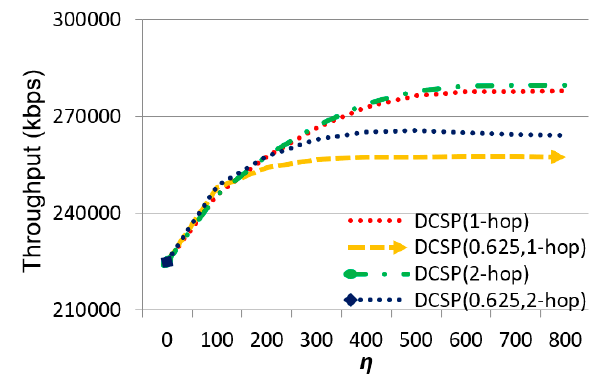
Figure 10. The effect of η on throughput (1-hop neighbors as candidates VS. 1-hope and 2-hop neighbors as candidates).